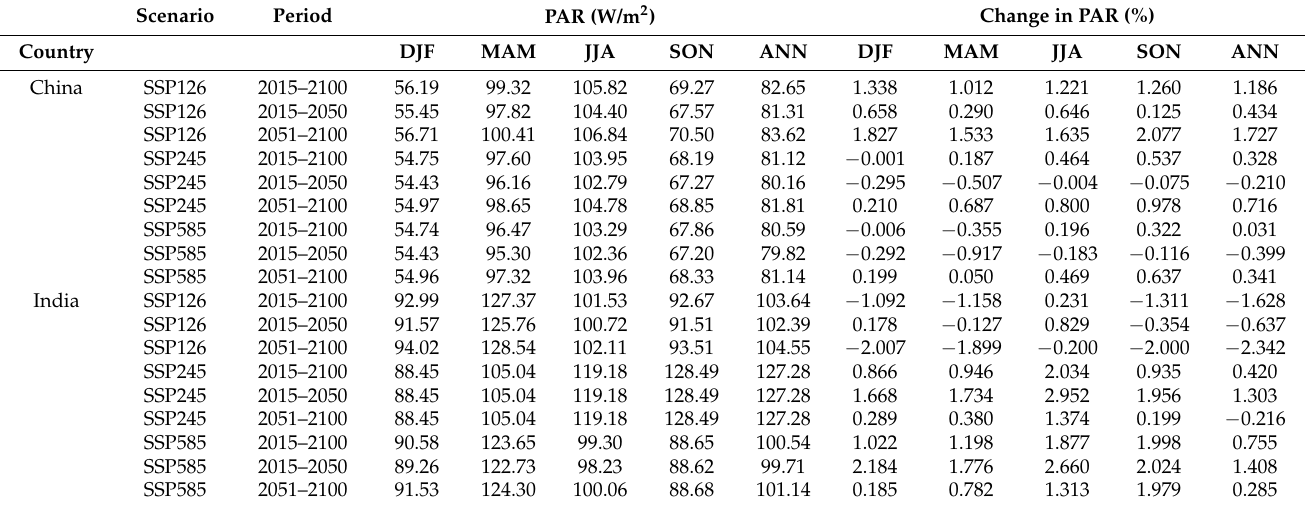
Table 10. Impacts of climate change on photosynthetically active radiation output in China and